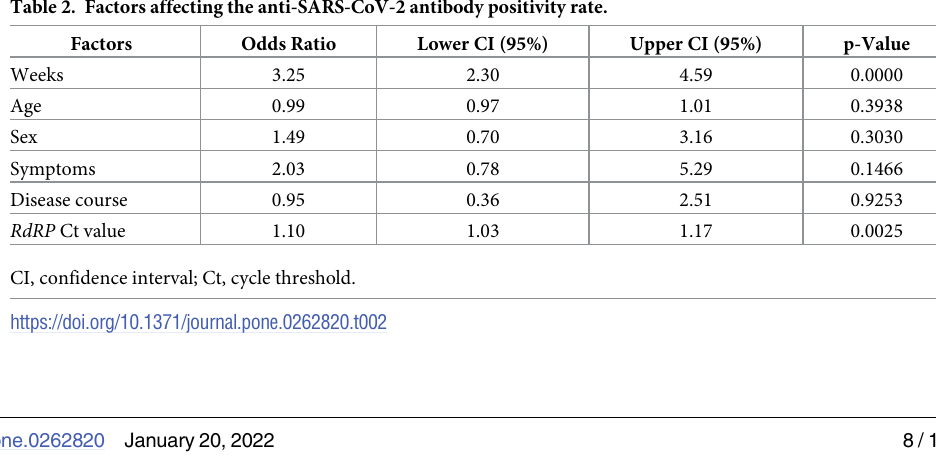
Table 2. Factors affecting the anti-SARS-CoV-2 antibody positivity rate. Factors